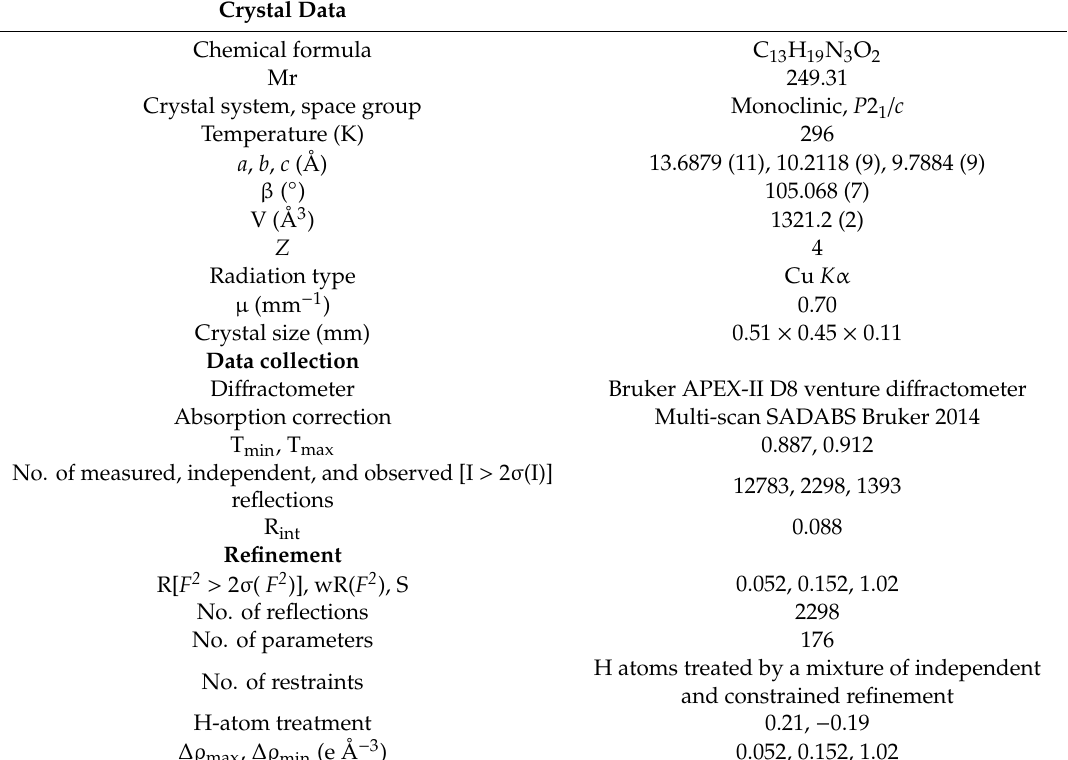
Table 2. Experimental details of 3a .